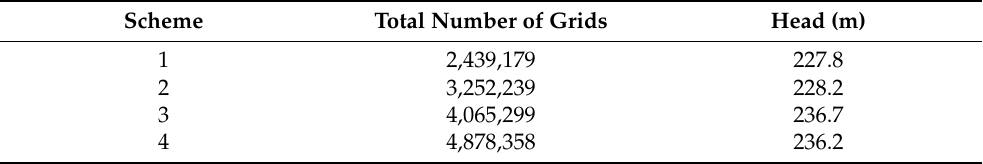
Table 3. Comparison of the calculated head under different grid